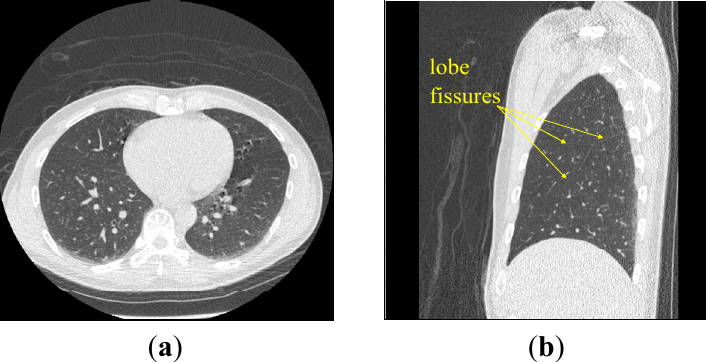
Figure 1. The lung CT image for ( a ) axial slice (whole lung) and ( b ) sagittal slice (right lung). Whole information of lung lobe is more suitable than axial views or coronal